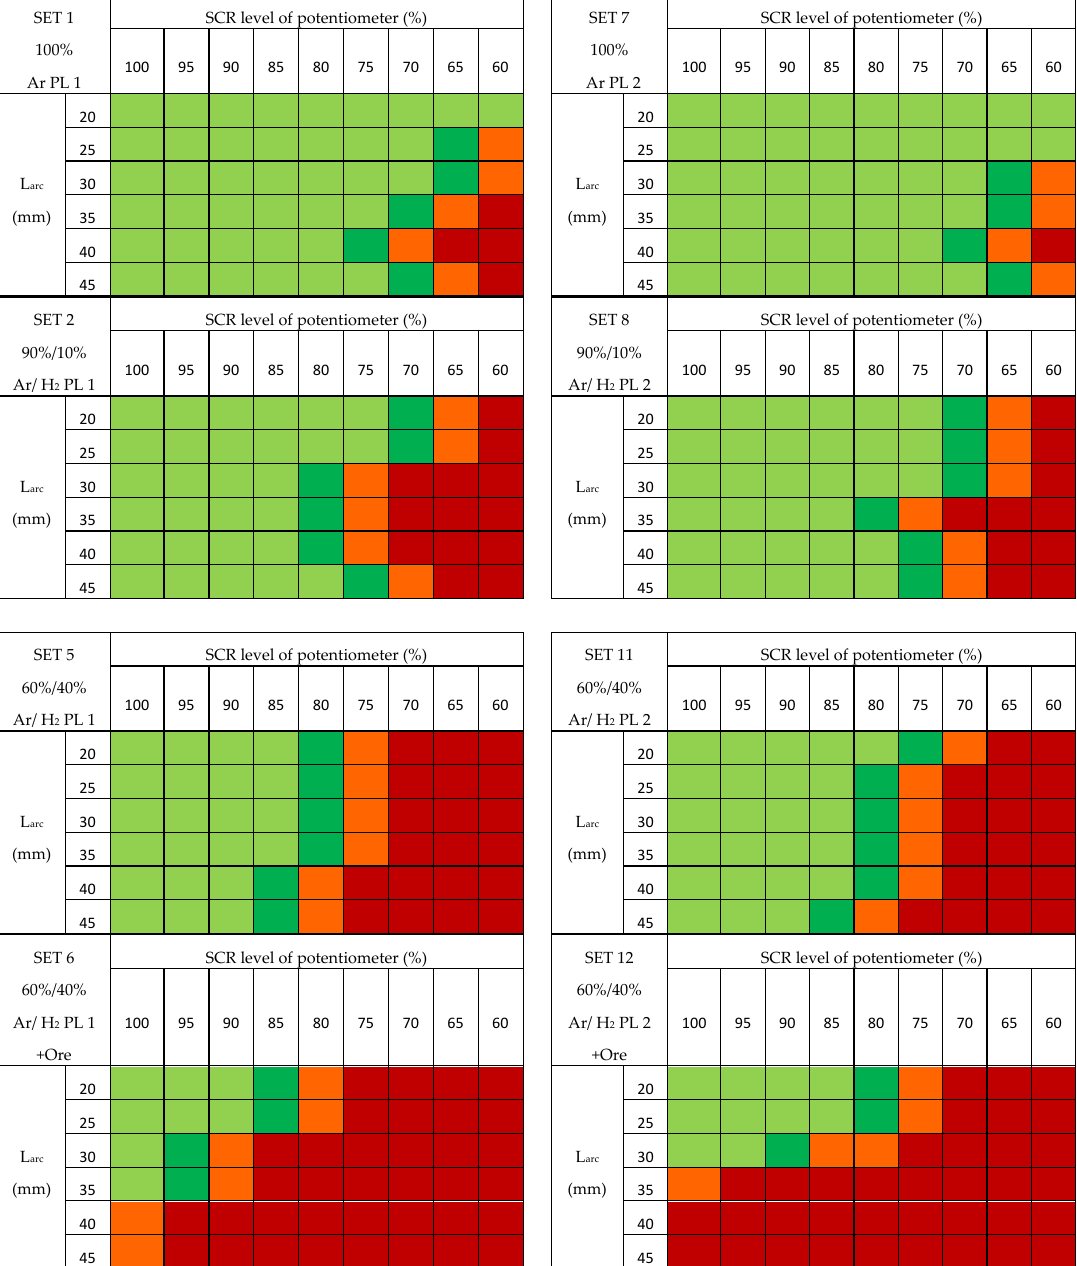
Table 9. Collection of arc stability maps for various conditions in the HPSR process for single gases and mixtures of argon and hydrogen.